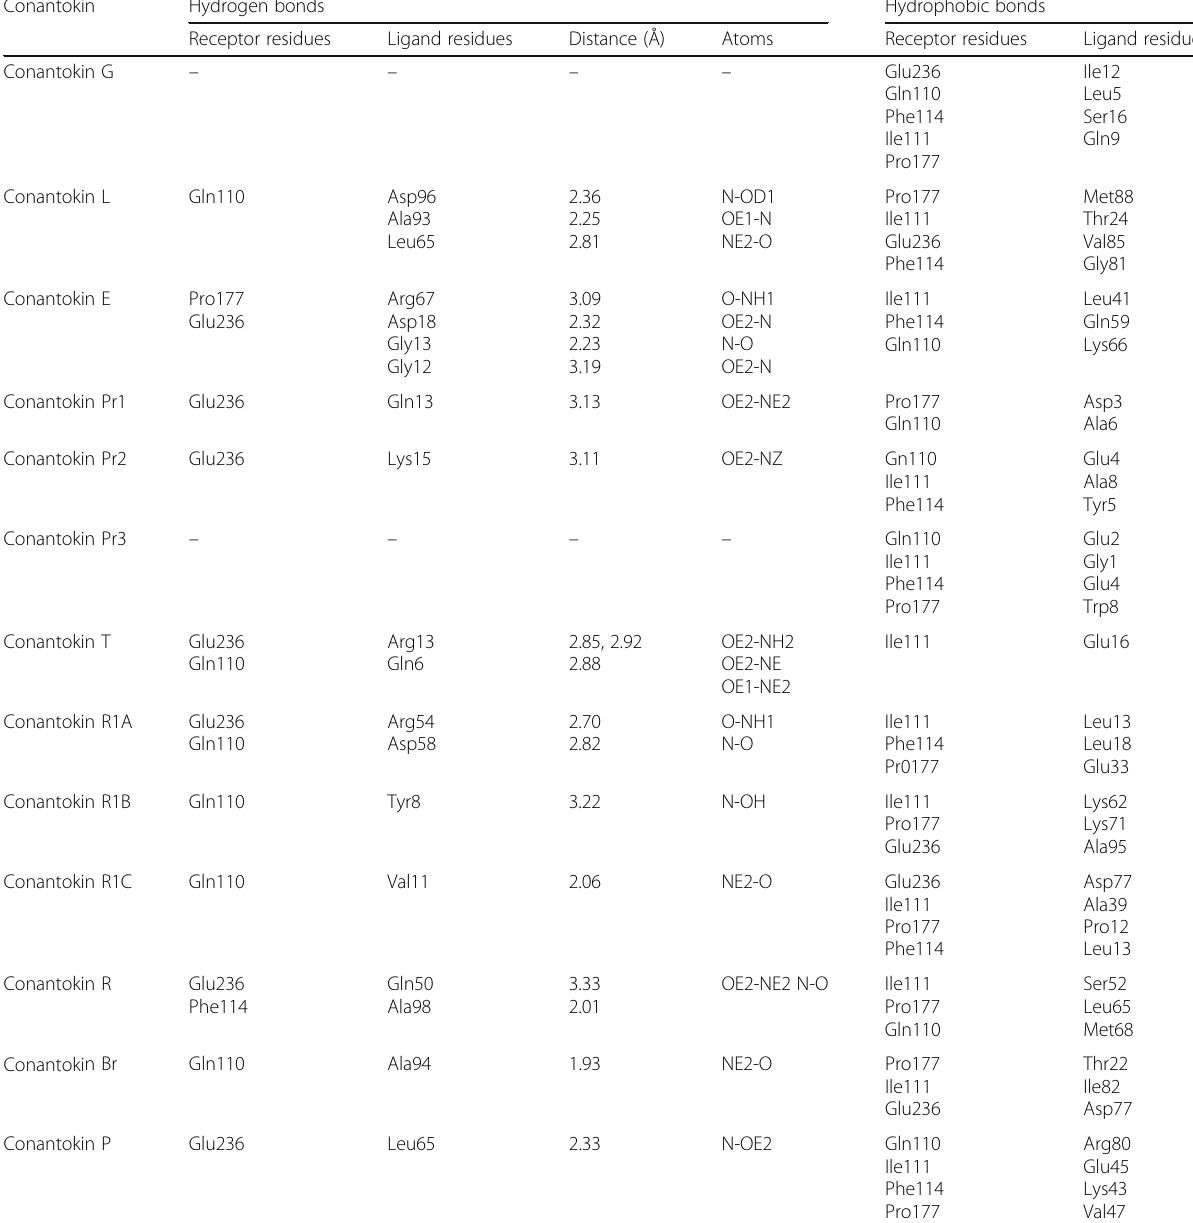
Table 2 Docking results of conantokin ligands in complex with NMDA receptor in humans